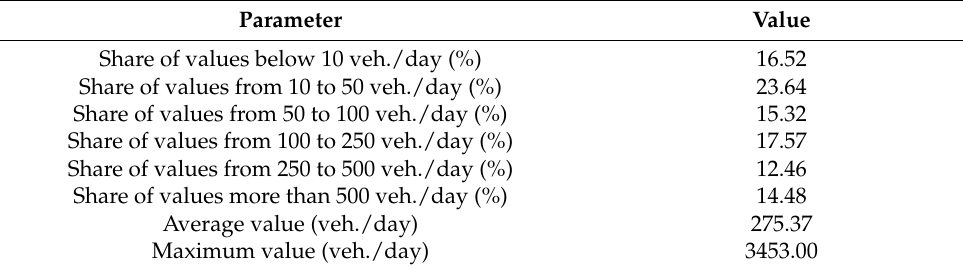
Table 5. Structure of the traffic volumes sample from GTM 2015.